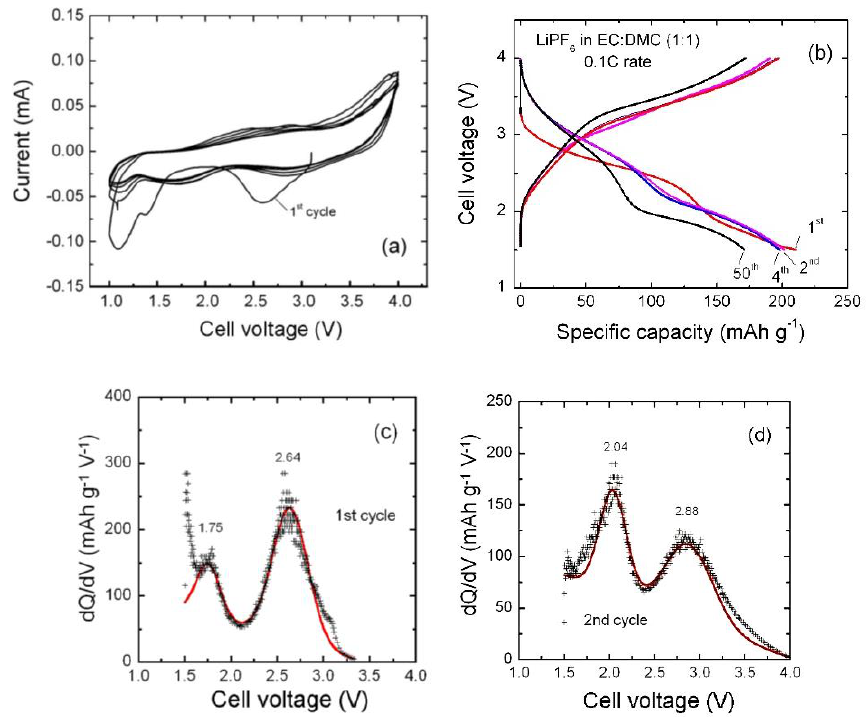
Figure 5. ( a ) Cyclic voltammograms of α-K 0.03 MnO 2 nanoneedles recorded at scan rate of 0.1 mV s −1 in the voltage range from 1.0 to 4.0 V. ( b ) Voltage profiles of a K 0.03 MnO 2 NNs//Li cell over 50 cycles